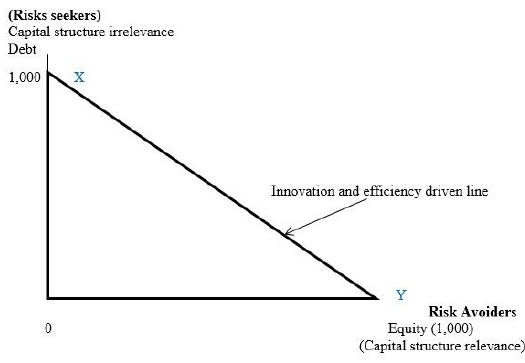
Figure 2. Entrepreneurial-Liability-Possibility Model: Turning Hopeless Situation to